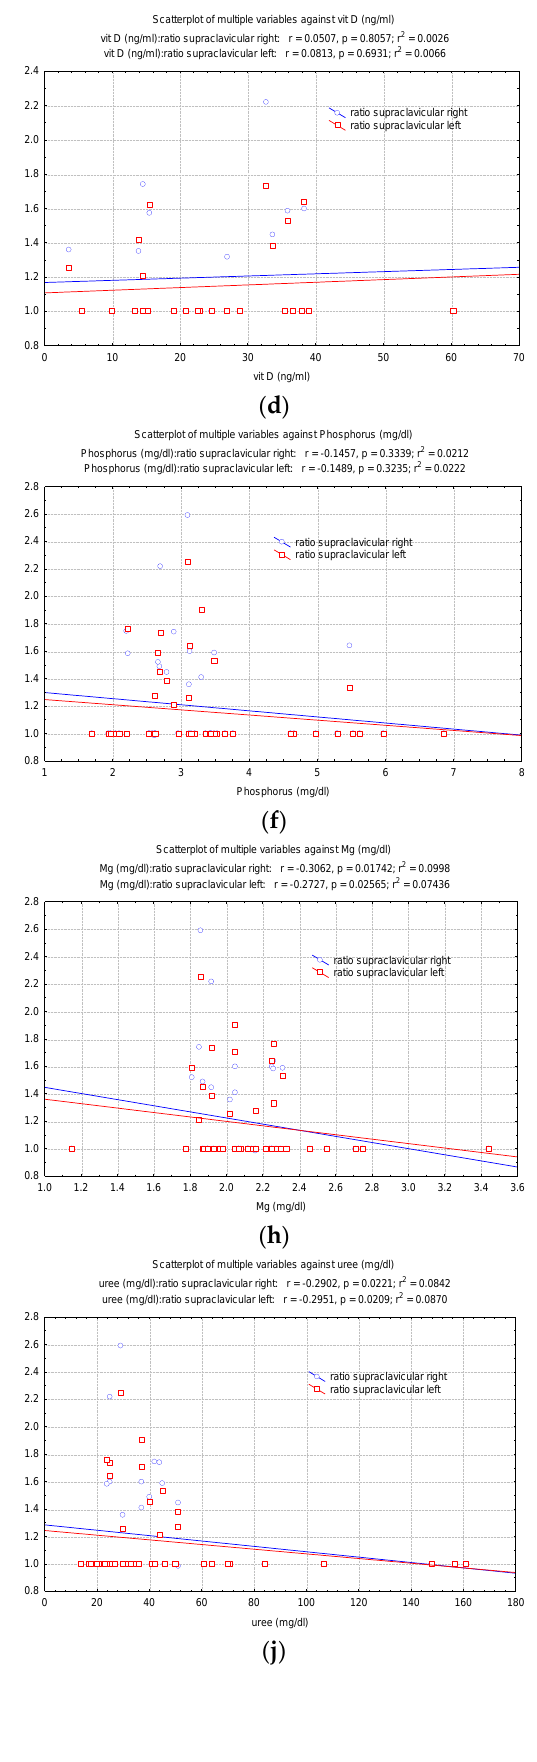
Scatterplot of multiple variables against Phosphorus (mg/dl) Phosphorus (mg/dl):ratio cervical right: r = -0.1349, p = 0.3713; r 2 = 0.0182 Phosphorus (mg/dl):ratio cervical left: r = -0.0500, p = 0.7416; r 2 = 0.0025